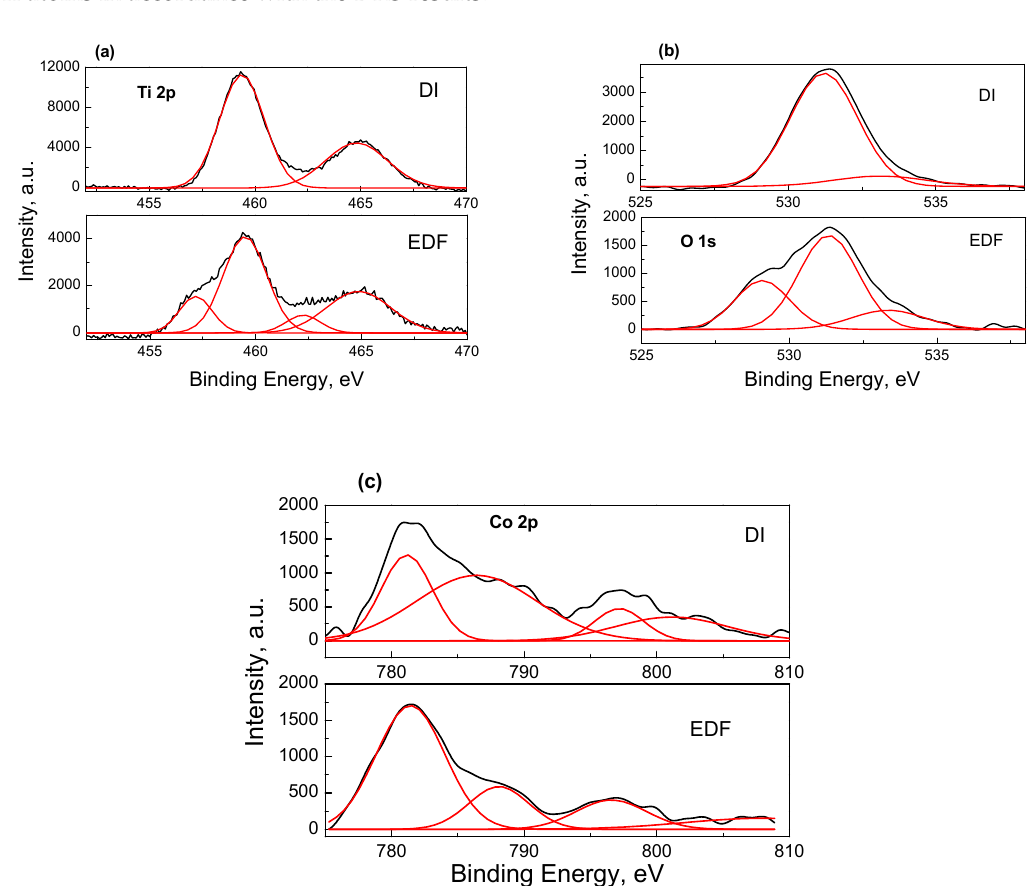
Figure 6. XPS spectra of Ti 2p ( a ), O 1s ( b ), and Co 2p ( c ) photoelectrons for the samples